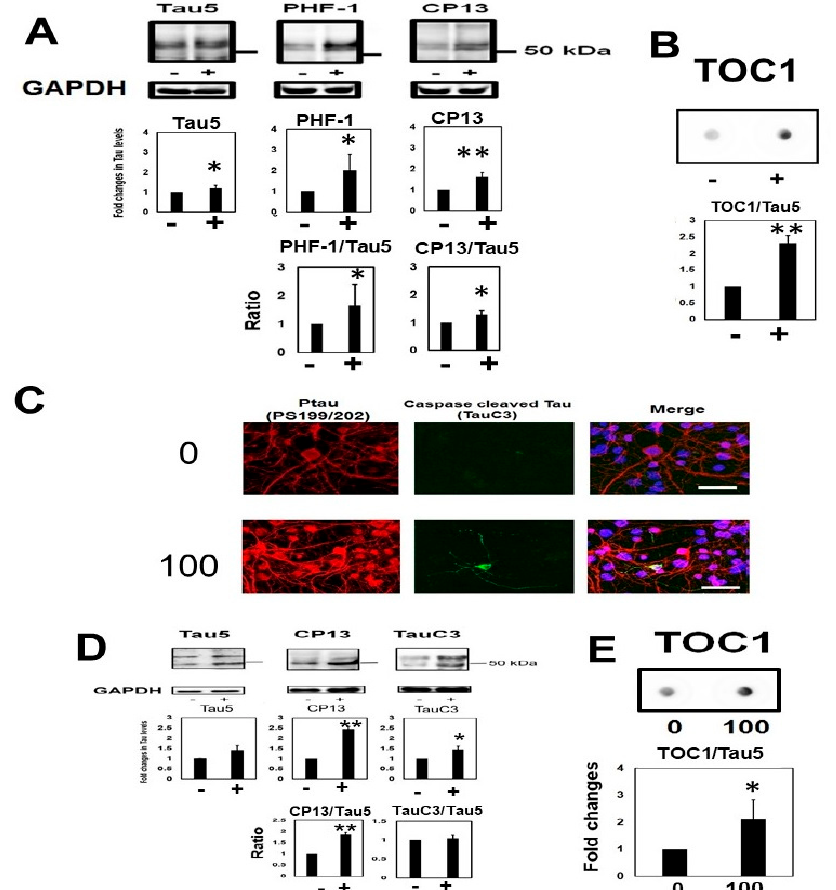
Figure 10. Homocysteine (Hcy) increased endogenous tau in M1Ccells and primary mouse